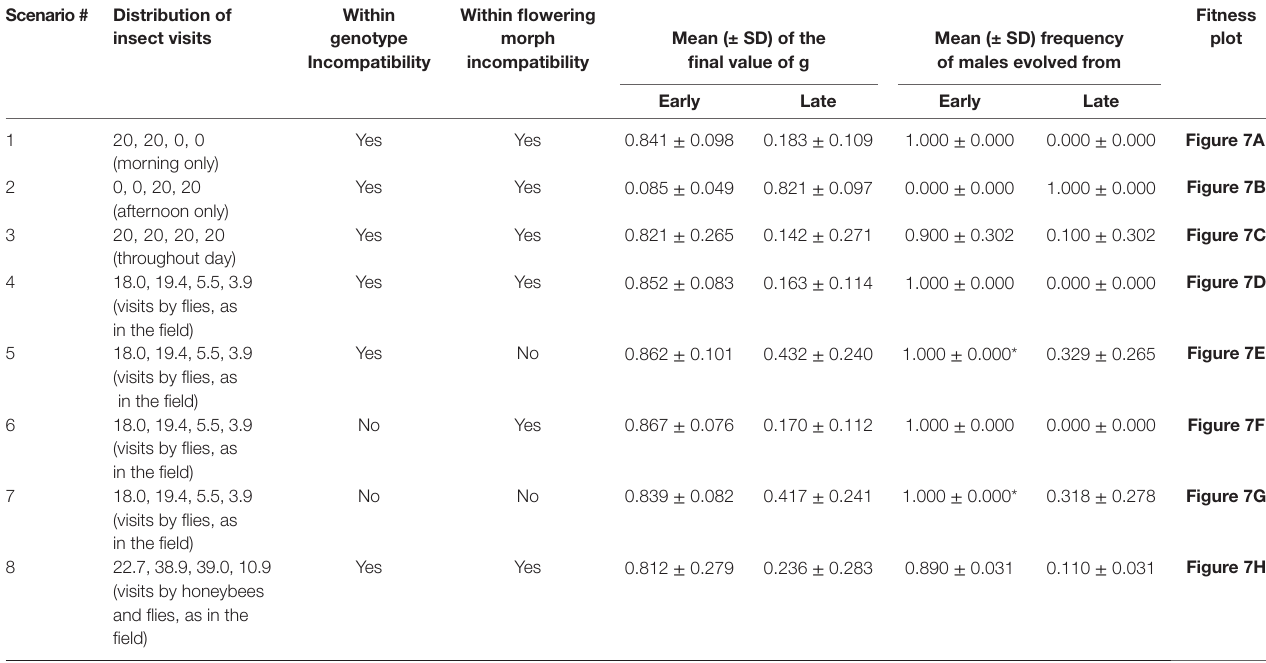
TABLE 2 | Summary of the results of the probabilistic simulation model done following eight different scenarios. Scenario # Distribution of insect